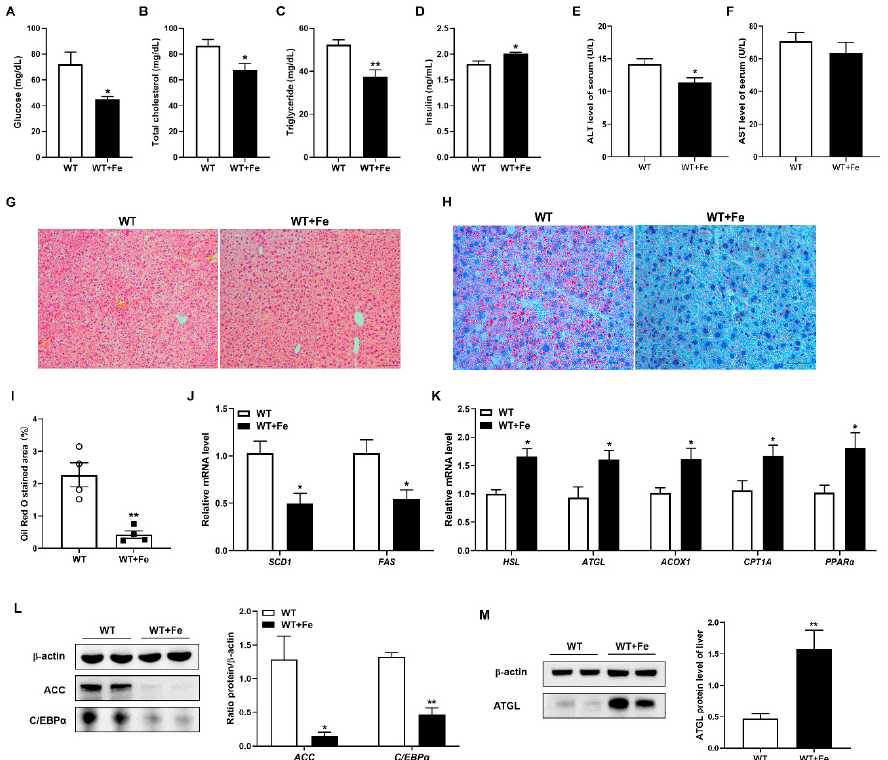
Figure 2. A high-iron diet inhibited adipogenesis and promoted lipolysis in liver. ( A ) Serum glucose. ( B ) Serum total cholesterol. ( C ) Serum triglycerides. ( D ) Serum insulin. ( E ) Serum AST. ( F ) Serum AST. ( G ) H&E staining of liver. ( H ) Oil Red O staining of liver. ( I ) Statistical area of lipid droplets ( n = 4). ( J ) SCD1 and FAS mRNA levels in liver. ( K ) HSL , ATGL , ACOX1 , CPT1A and PPAR α mRNA levels in liver. ( L ) ACC and C/EBP α protein levels in liver. ( M ) ATGL protein levels in liver. Data are presented as the mean ± SEM. * p < 0.05, ** p < 0.01. Original western blot figures in Figure S1.